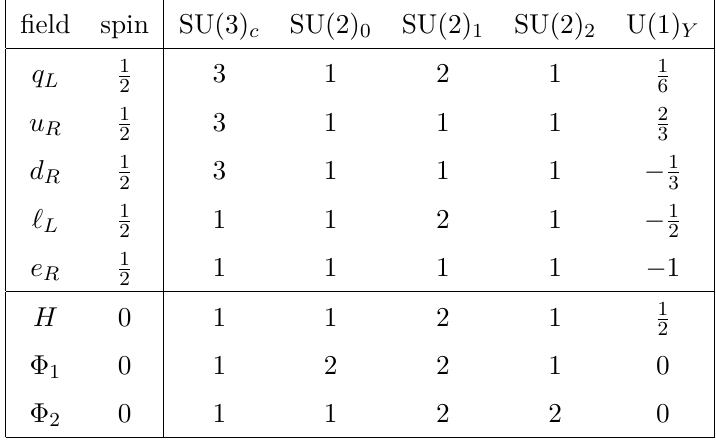
Table 1 . The matter and Higgs fields and their gauge charges. The generation indices for the matter fields are